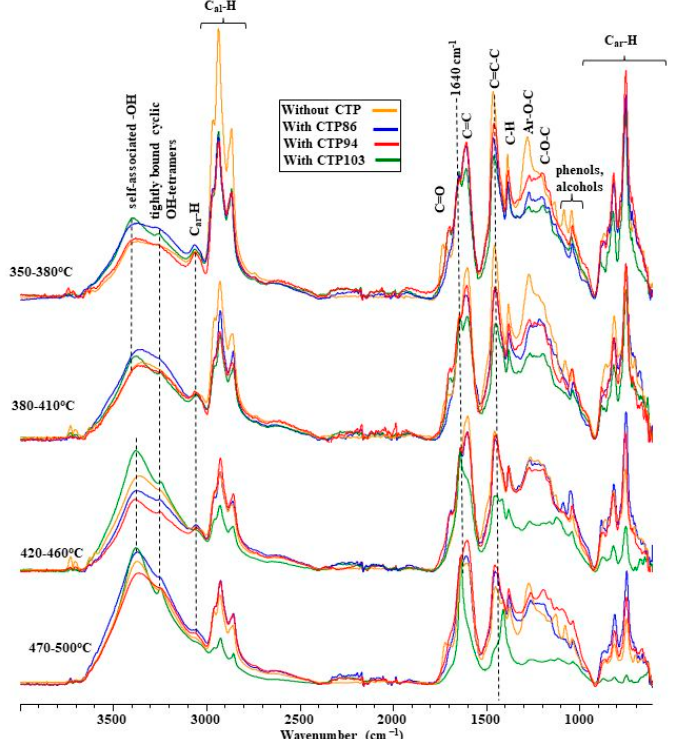
Figure 9. ATR spectra of material that was rinsed from the surface of grains and extracted from the gas-saturated and compacted zones.